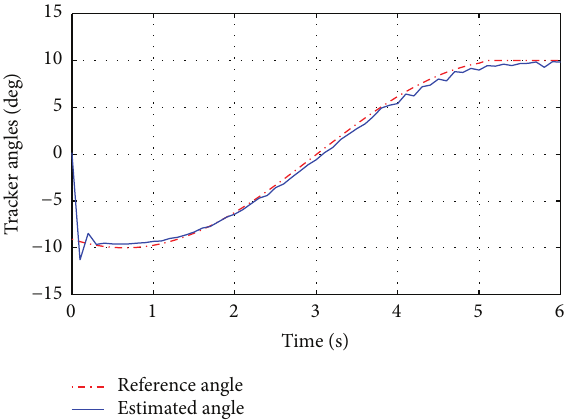
Figure 19: Angle trajectories for vehicle B tracker.